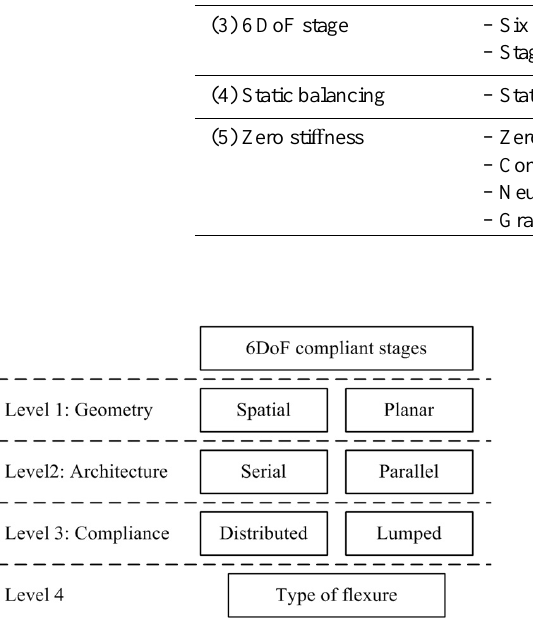
Figure 1. Schematic representation of the classification levels to compare the 6DoF compliant